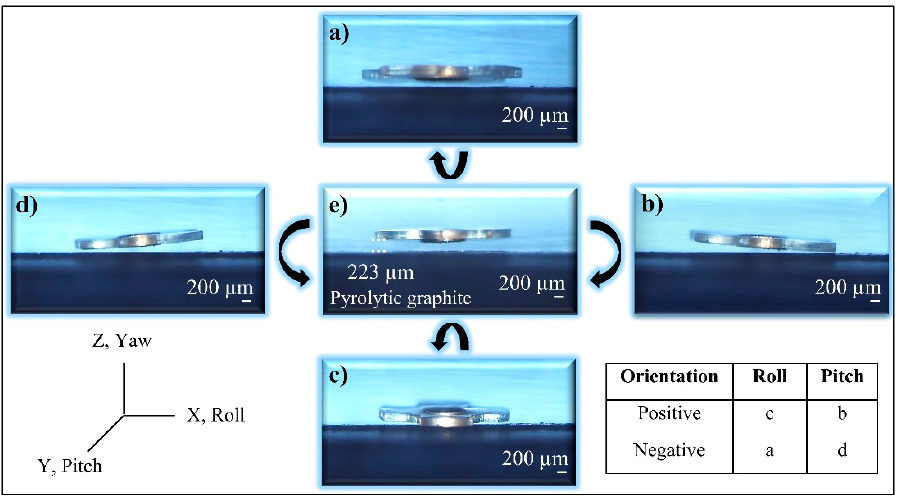
Figure 12. Axial orientations of the robot are shown. ( e ) is the initial position at 223 µm levitation height, ( a , c ) shows negative and positive roll angle respectively, and ( b , d ) shows positive and negative pitch angle, respectively.